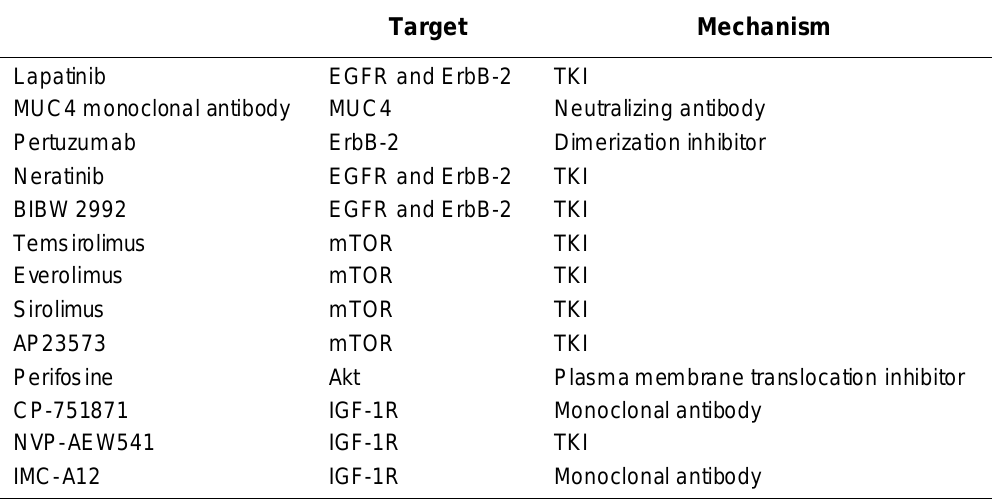
Novel Therapeutic Strategies for Trastuzumab-Resistant Breast